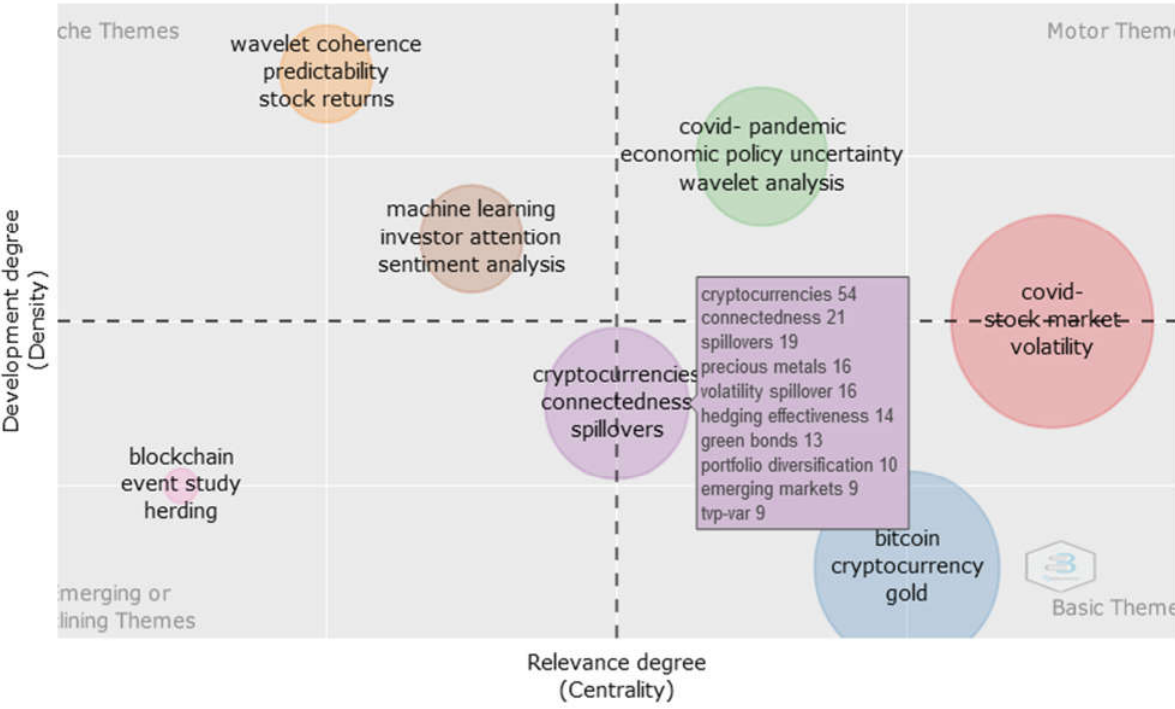
Figure 4. Thematic map.